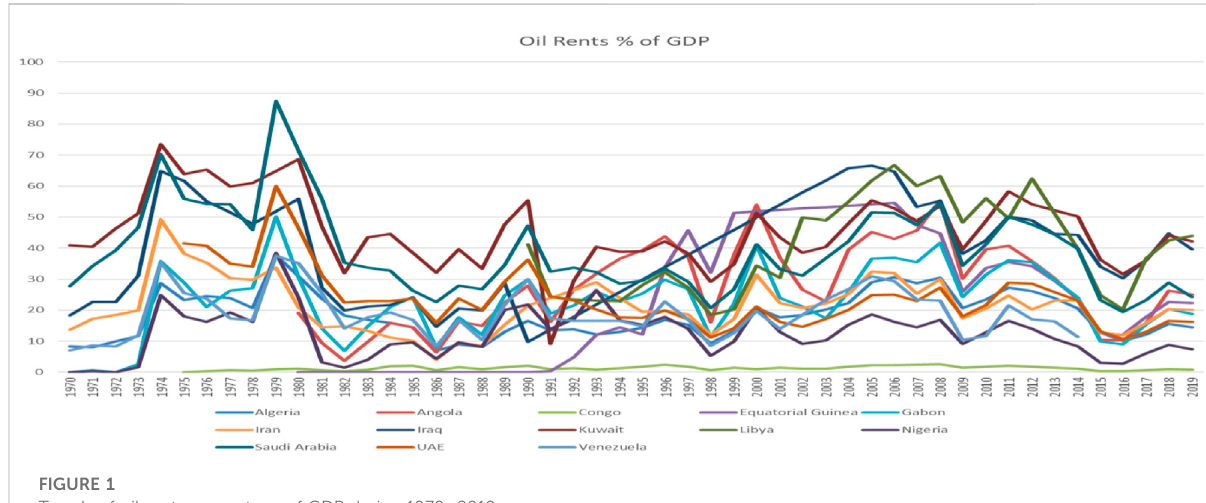
FIGURE 1 Trends of oil rents percentage of GDP during 1970 –